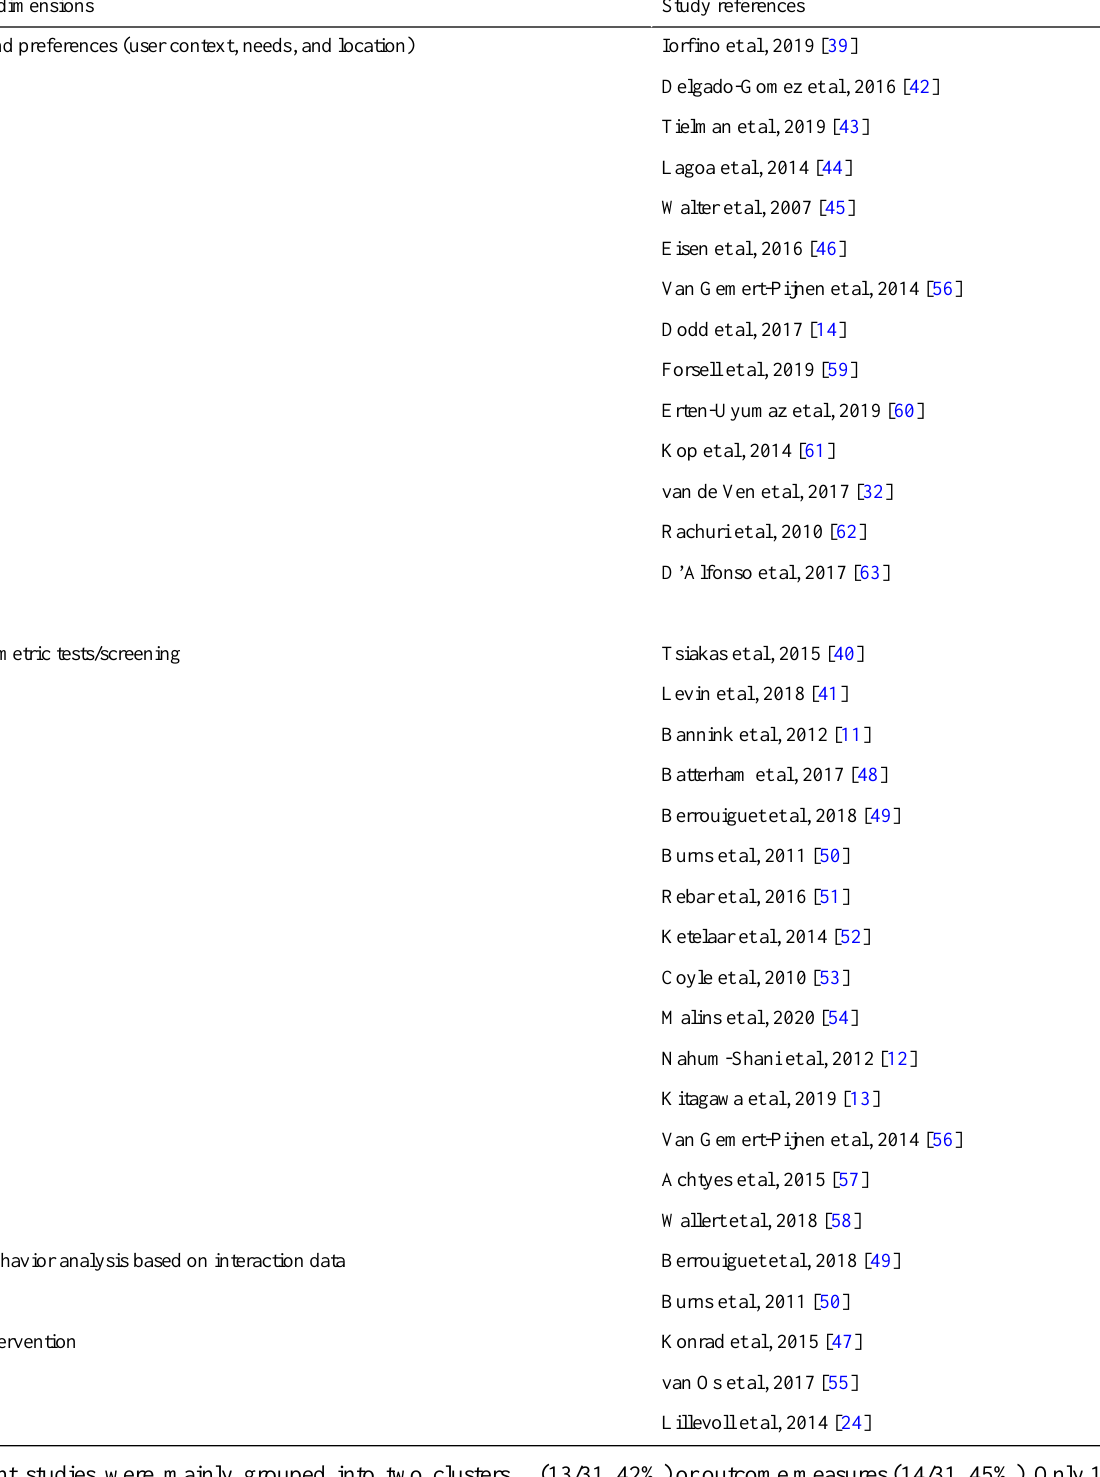
Table 4. Dimensions considered for adaptation in the relevant